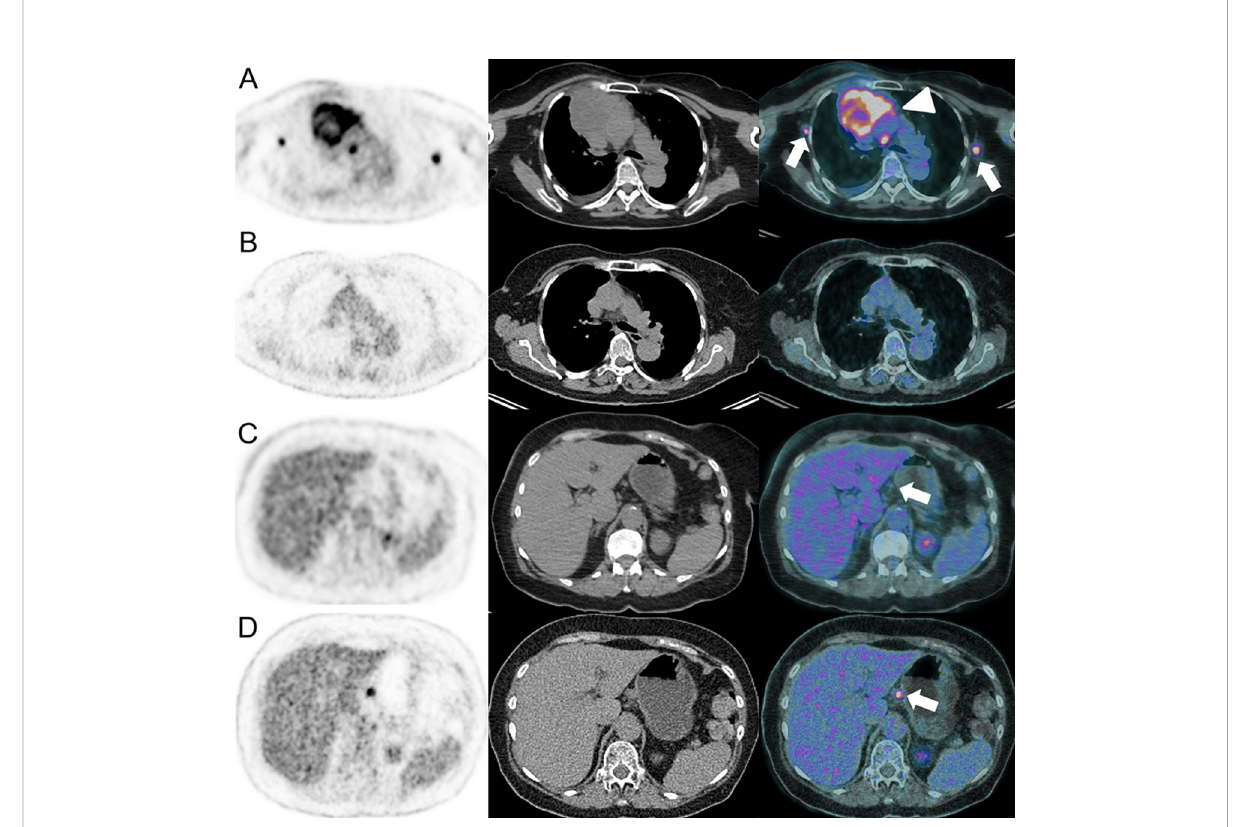
FIGURE 7 Dissociated response in a 63-year-old female with left lower leg Meckel carcinoma and mediastinal [ (A) , arrowhead] and axillar [ (A) , arrows] metastatic spread as demonstrated on baseline 18 F-FDG-PET/CT (A) . Pembrolizumab (anti-PD-1) was administered. At the 6-months follow-up, 18 F-FDG-PET/CT showed complete response on the mediastinal and axillar lymph nodes (B) . However, a hypermetabolic coeliac lymph node appeared [ (D) , arrow], which was not present at baseline [ (C) ,